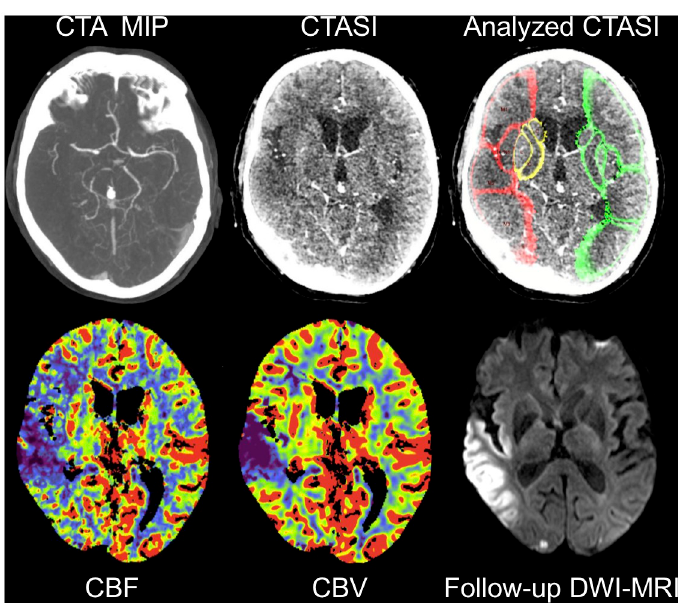
Fig 3. Case example of a 76-year-old male patient. CTA MIP shows a proximal M1 occlusion on the right side with consecutive cerebral blood flow and blood volume deficit on CTP. Noncontrast CT ASPECTS on admission was interpreted as 8 by both readers (not displayed). CTASI ASPECTS was 7 for reader 1 and 8 for reader 2. CTA source images without and after automated segmentation and attenuation measurements in ASPECTS regions presenting deficit of contrast uptake in the affected regions. Colors indicate reduction in regional x-ray attenuation compared with the contralateral hemisphere (green = difference < 1 HU; yellow = difference � 1 and < 3 HU; red = difference > 3 HU). Notably, the analysis provides good match with ischemic hypoperfusion on CBF maps but overestimates infarction core on CBV and final infarction displayed on follow-up diffusion-weighted MRI after complete recanalization (mTICI 3). Abbreviations: CTA, CT angiography; MIP, maximum intensity projection; CTP, CT perfusion; CBF, cerebral blood flow; CBV, cerebral blood volume; DWI, diffusion-weighted imaging; ASPECTS, Alberta Stroke Program Early CT Score; mTICI, modified Treatment in Cerebral Ischemia